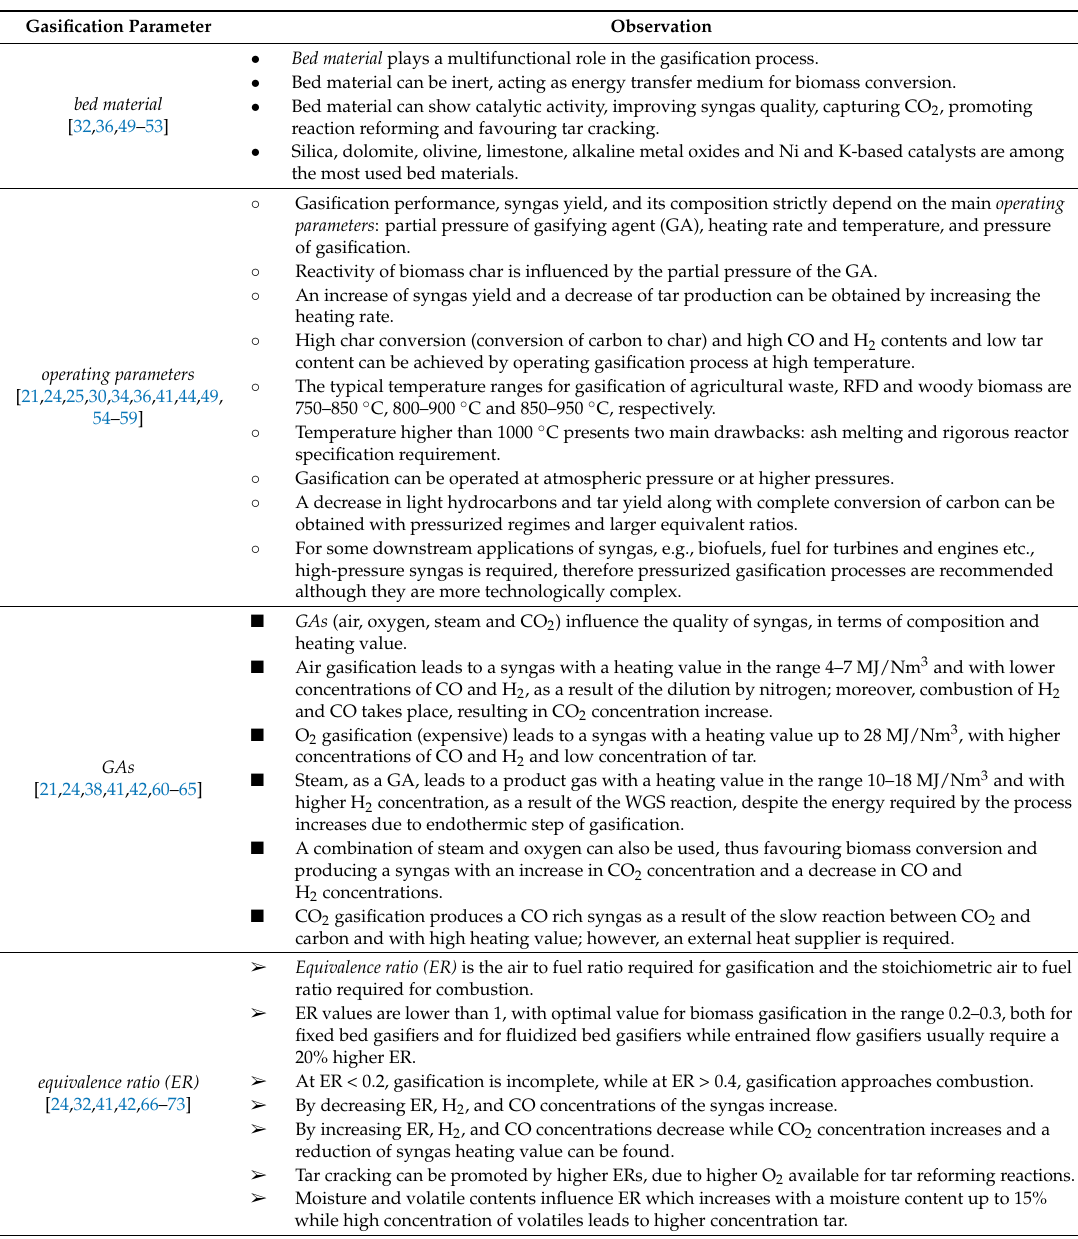
Table 3. Effect of operating conditions on the gasification process